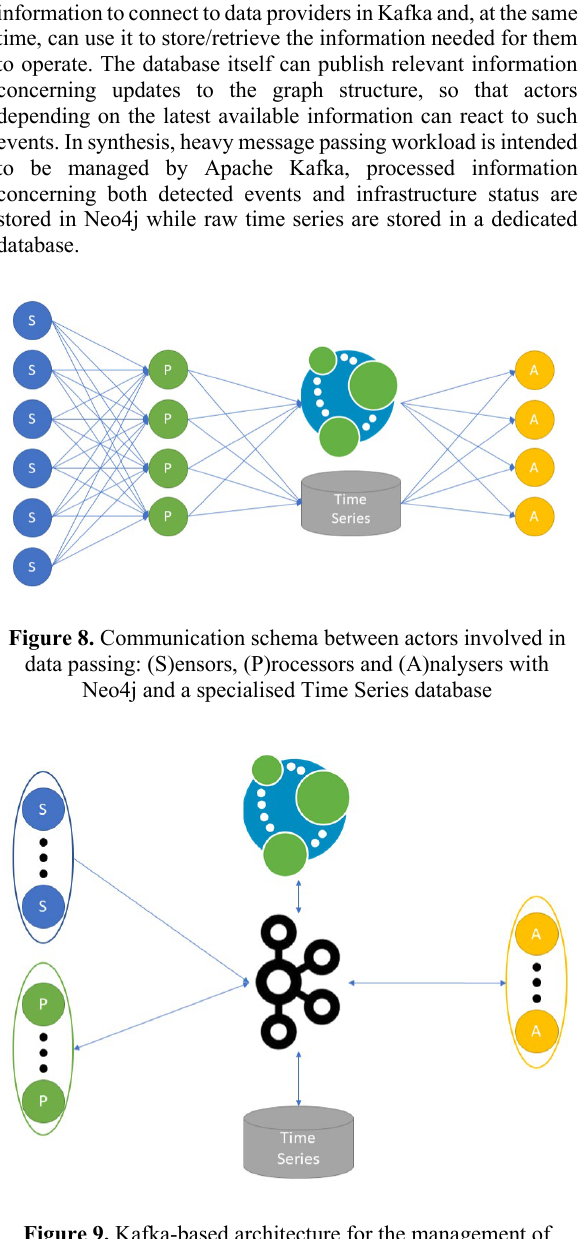
Figure 9. Kafka-based architecture for the management of message